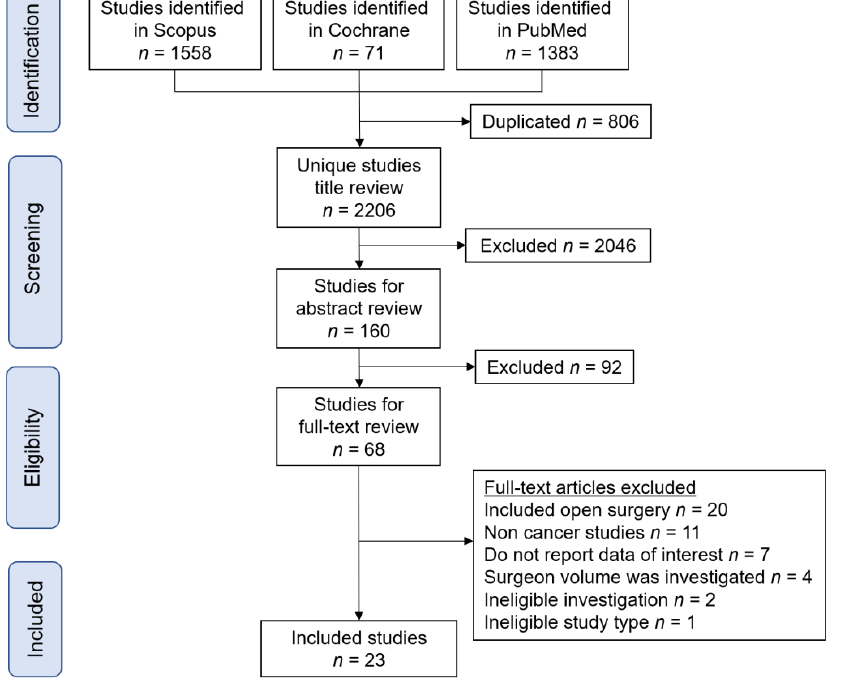
Figure 1. Selection schema for the systematic review of the literature.